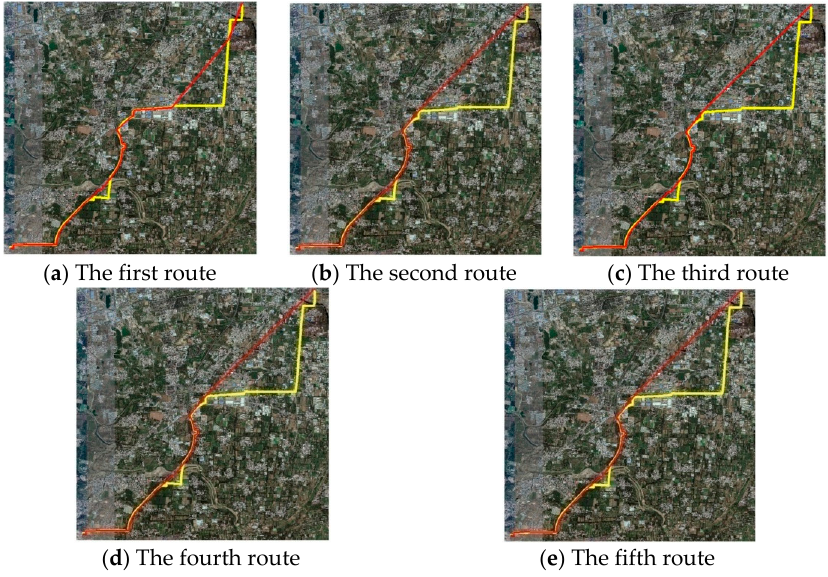
Figure 19. Top 5 routes of the modified ACO module.